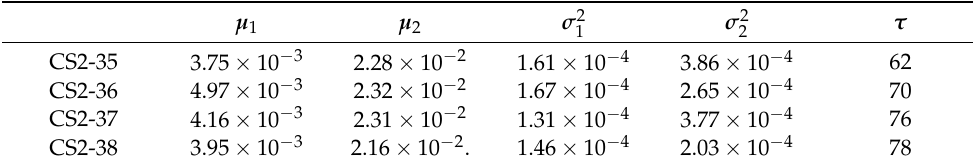
Table 2. Offline parameter estimates of CS2-35, CS2-36, CS2-37, and CS2-38. 𝝁 𝟏 𝝁 𝟐